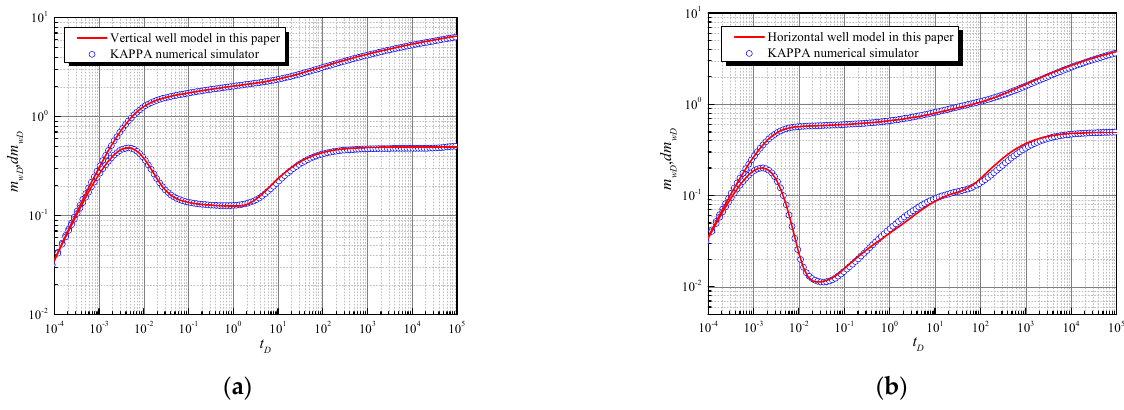
Figure 4. Pressure comparison results between the model in this paper and the numerical simulation from KAPPA: ( a ) the vertical well model; ( b ) the horizontal well model. Table 1. Model validation parameters for vertical and horizontal wells with composite features in underground natural gas storage.